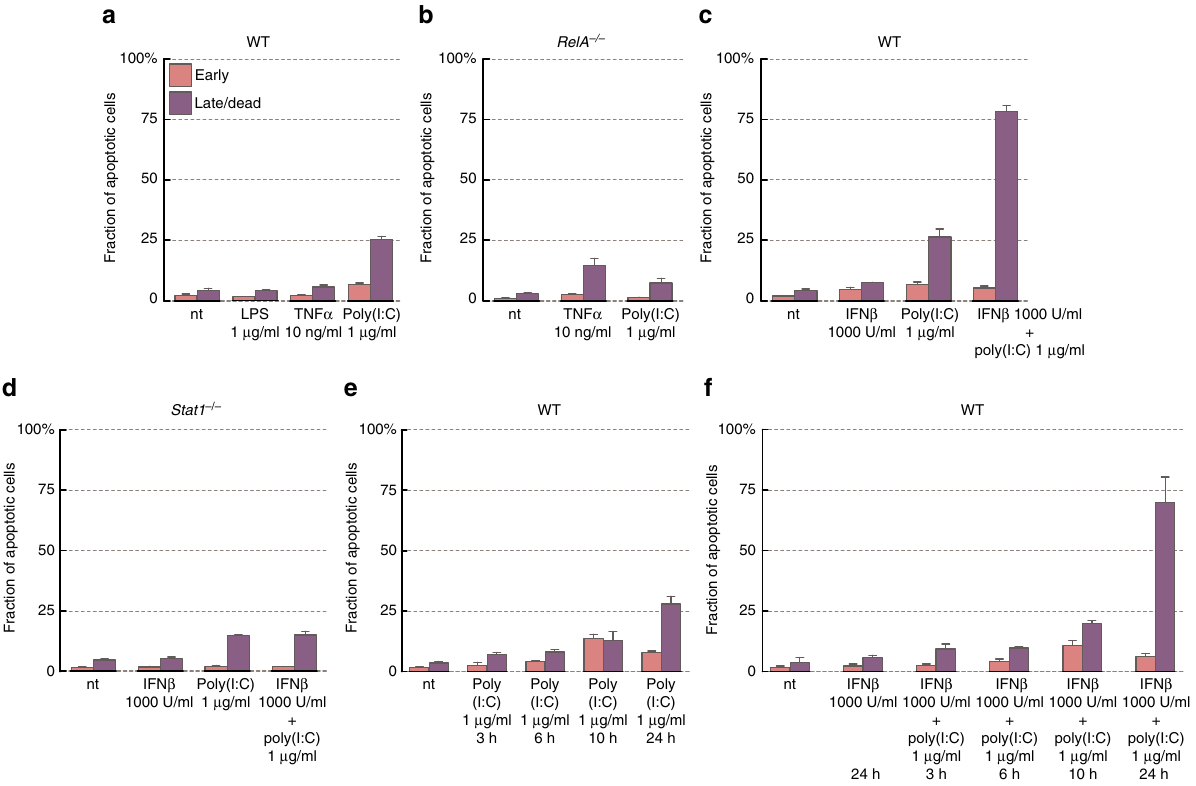
Fig. 8 Apoptotic cell fraction in response to LPS, TNF α , poly(I:C) or IFN β . Bars show mean fractions of early apoptotic (pink) and late apoptotic/dead cells (purple), estimated by Annexin V/PI staining (bars represent means ± s.d., n ≥ 3, data for all replicates are given in the Supplementary Data 14). See Supplementary Fig. 8 for density plots of Annexin V/PI staining. a Fraction of apoptotic WT MEFs in response to 1 μ g/ml LPS, 10 ng/ml TNF α or 1 μ g/ml poly(I:C) after 24 h of treatment. b Fraction of apoptotic RelA – / – MEFs in response to 24-hr stimulation with 10 ng/ml TNF α or 1 μ g/ml poly(I:C). c Fraction of apoptotic WT MEFs in response to 24-hr treatment with 1 μ g/ml poly(I:C) following 24 h of quiescence or 1000 U/ml IFN β pre-stimulation. d Fraction of apoptotic Stat1 – / – MEFs in response to 24 h of 1000 U/ml IFN β stimulation, 1 μ g/ml poly(I:C) 24 h treatment, or response to 24 h treatment with 1 μ g/ml poly(I:C) after 24 h of 1000 U/ml IFN β pre-stimulation. e Apoptotic fraction time course for WT MEFs in response to 1 μ g/ml poly(I:C). f